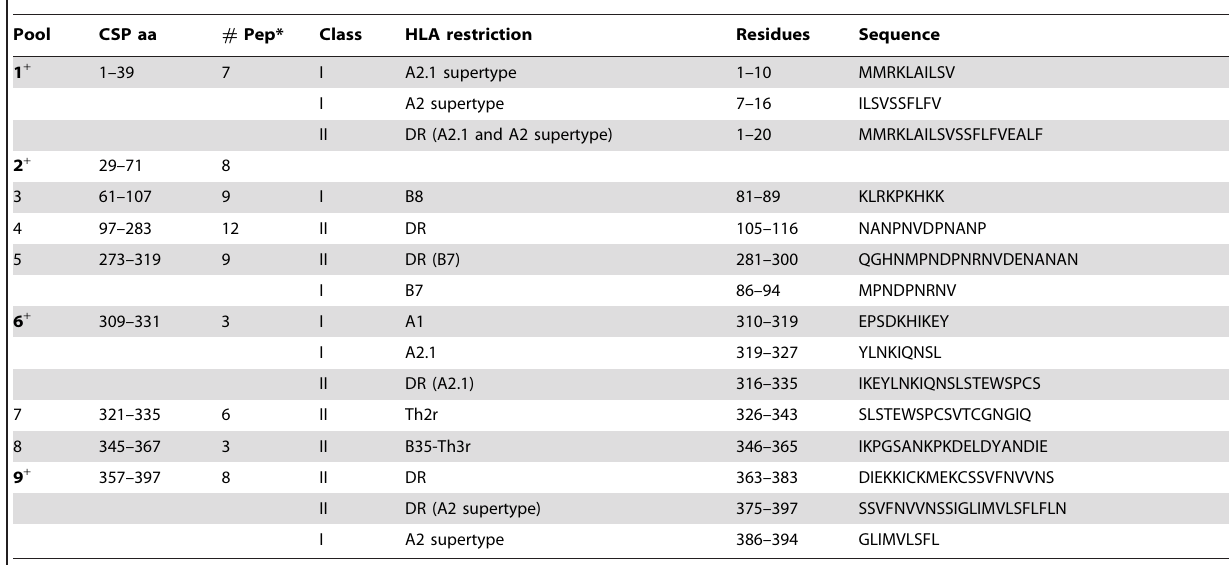
Table 2. CSP peptides used in ELISpot and ICS assays.